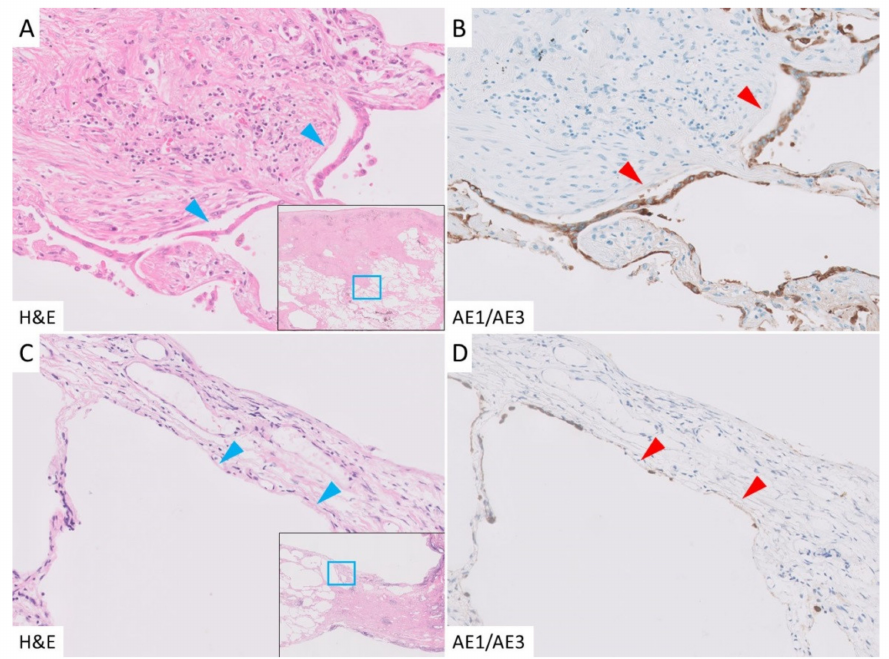
Figure 3. Epithelial denudation in the PPFE group. ( A ): Alveolar epithelial denudation (AED) was detected in the border between the subpleural fibroelastosis and normal lung (blue arrowhead). ( B ): Cytokeratin AE1/AE3 immunohistochemical staining. The denudated epithelium and detached surface were highlighted in this staining (red arrowhead). ( C , D ): AED was also seen in the subpleural area without fibroelastosis (arrowhead).